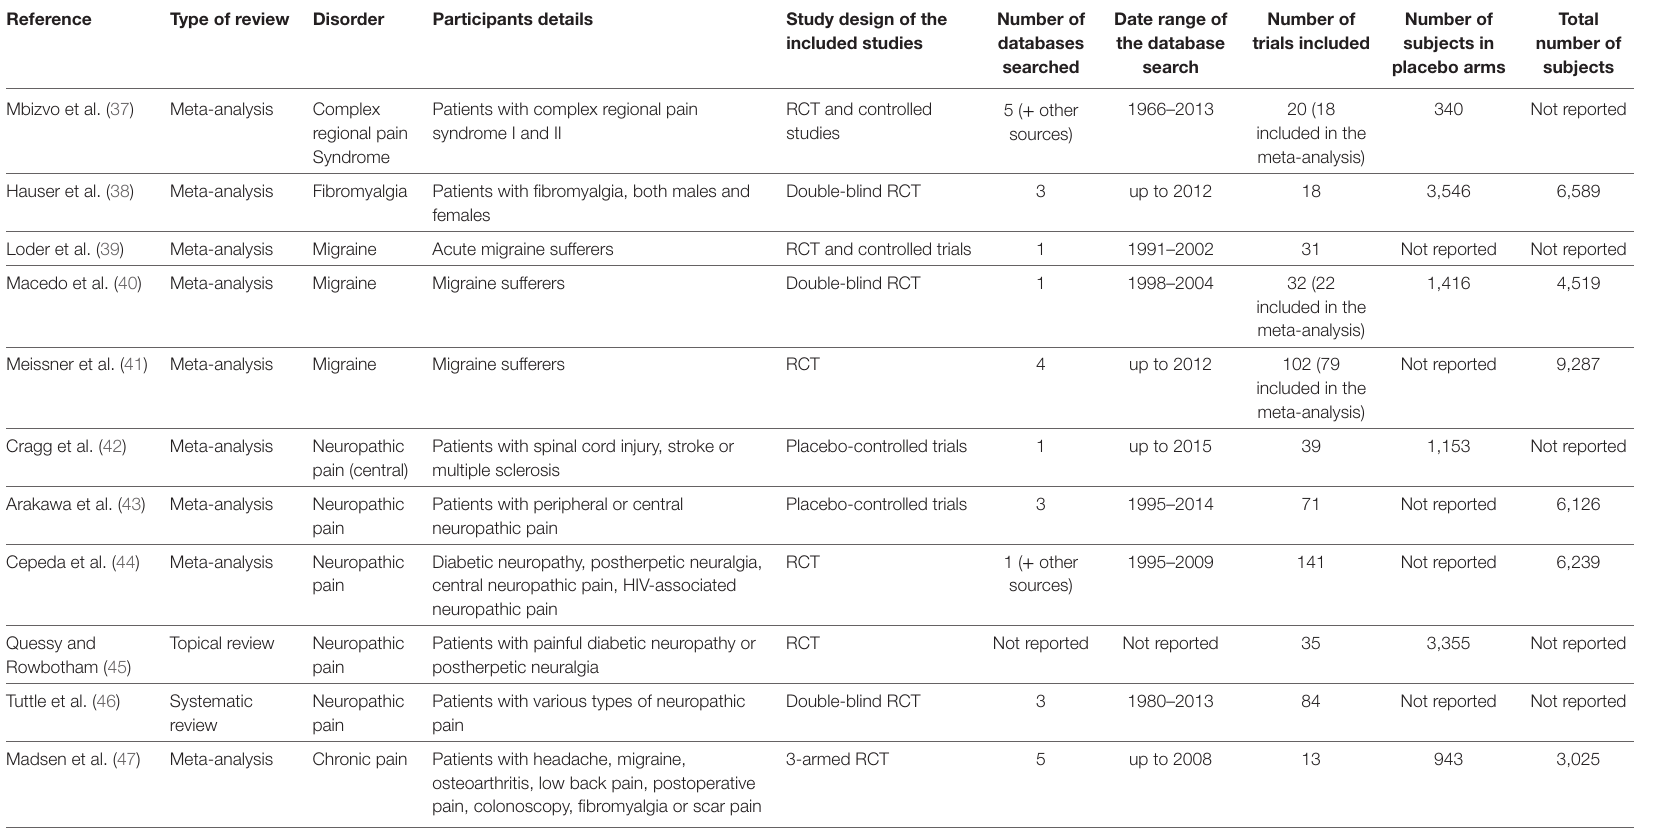
RCT, randomized controlled